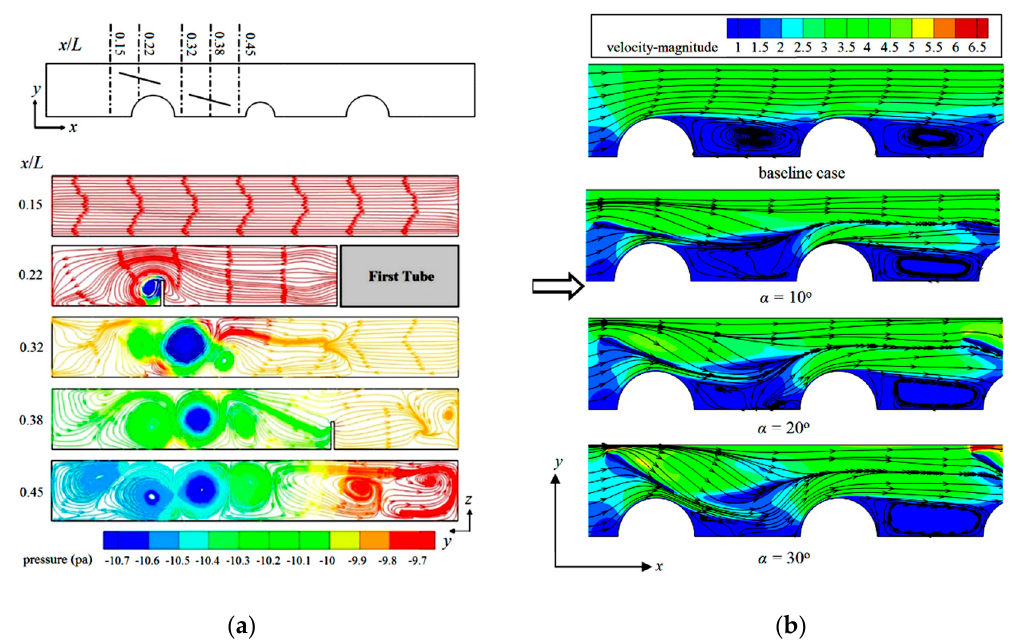
Figure 10. Streamlines and velocity distributions caused by VGs. ( a ) Streamlines colored by pressure in different cross sections for Re = 1000 [103]. ( b ) Local velocity distributions on the middle cross section for baseline case and enhanced cases for Re = 850 [93].